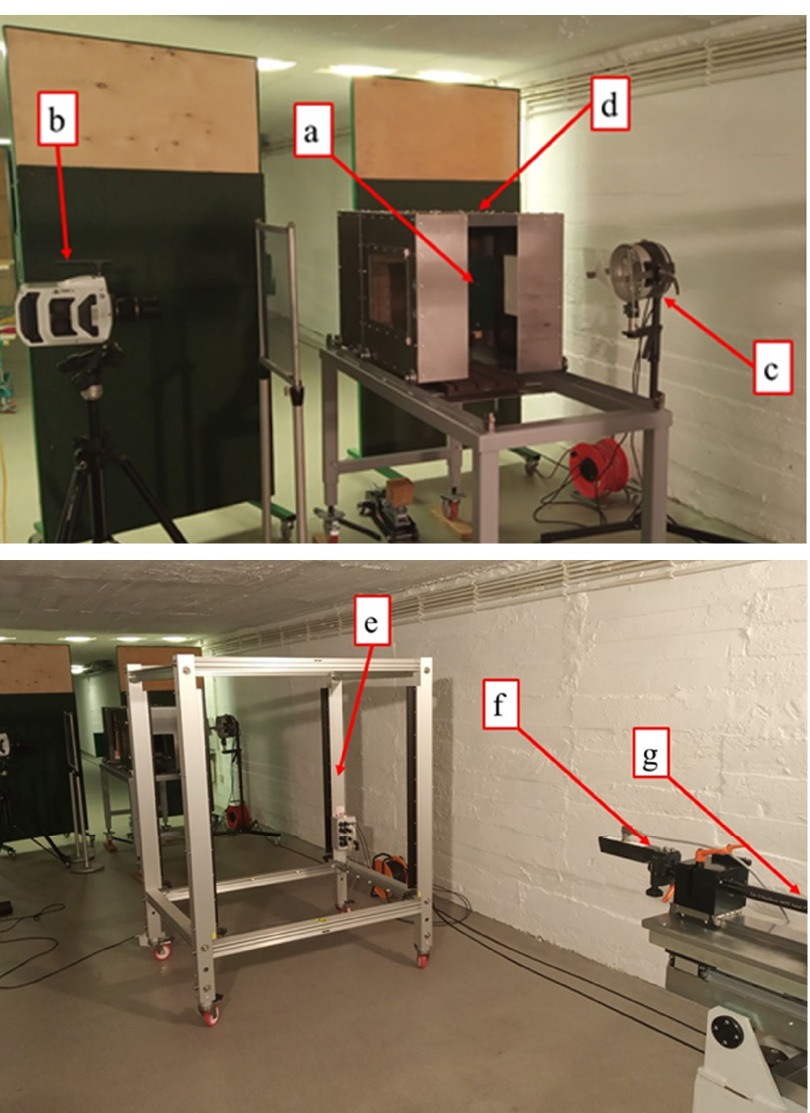
Figure 4. Experimental stand for terminal ballistics tests: ( a ) investigated specimen mount, ( b ) high-speed camera, ( c ) light source, ( d ) protective box with bullet catcher, ( e ) intelligent light screen, ( f ) electromagnetic muzzle device, and ( g ) barrel launching system, calibre 5.56 mm.